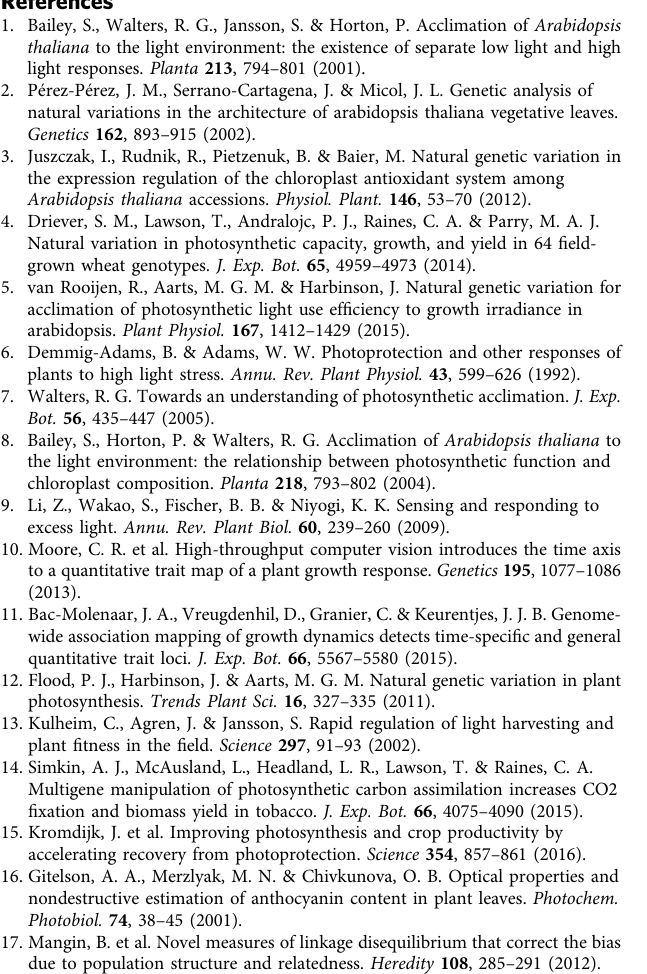
Table 4. We chose the accessions CS76113, CS28193, CS28492, and CS76297 to represent allele 1; the accessions CS76305, CS28685, CS76218, and CS76153 to represent allele 3; and the accessions CS28787, CS76133, CS76129, and CS76128 to represent allele 4. One-way ANOVA was used for testing signi fi cance. The changes in expression were calculated for each genotype by averaging the gene expression at LL conditions (LL average) and then determining the fold difference for the HL expression compared to the LL